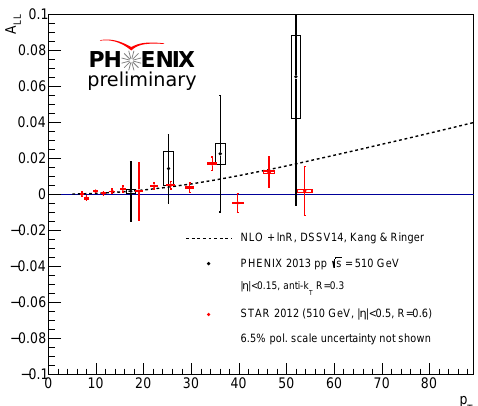
Figure 5: Jet A as a function of p compared with NLO pQCD calculations with LL T ln(R) resummations. The bars represent statistical uncertainties and square brackets are for systematic uncertainties. The measurement from RHIC run 2012 at STAR is shown as a